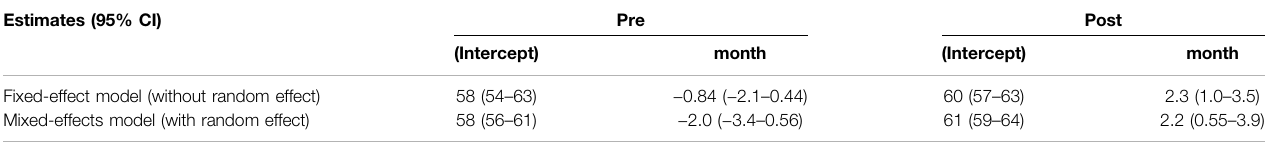
TABLE 2 | Effects of predictor variables. Estimates (95%